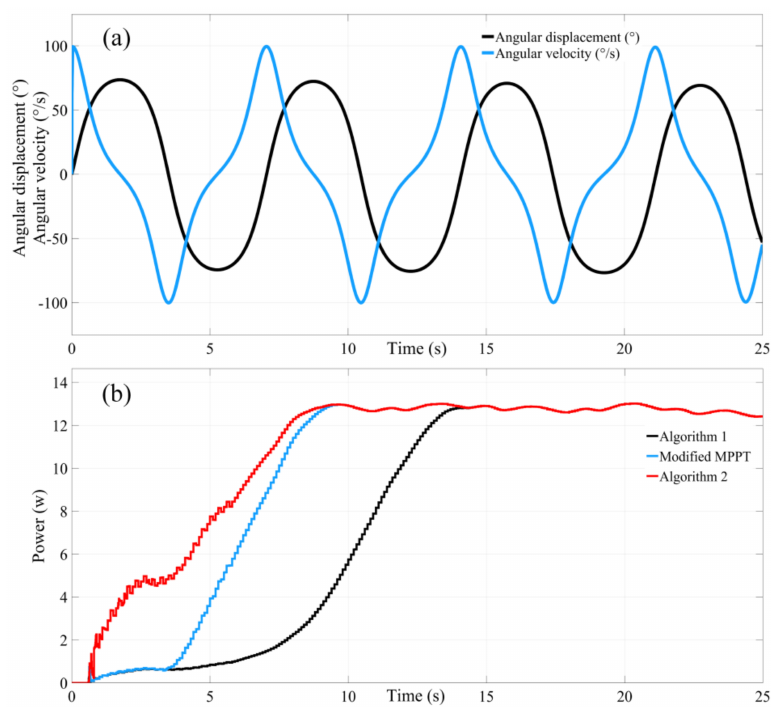
Figure 21. Algorithm comparison of rated sea conditions: ( a ) precession angular displacement and angular velocity under rated conditions; ( b ) power output of three methods.